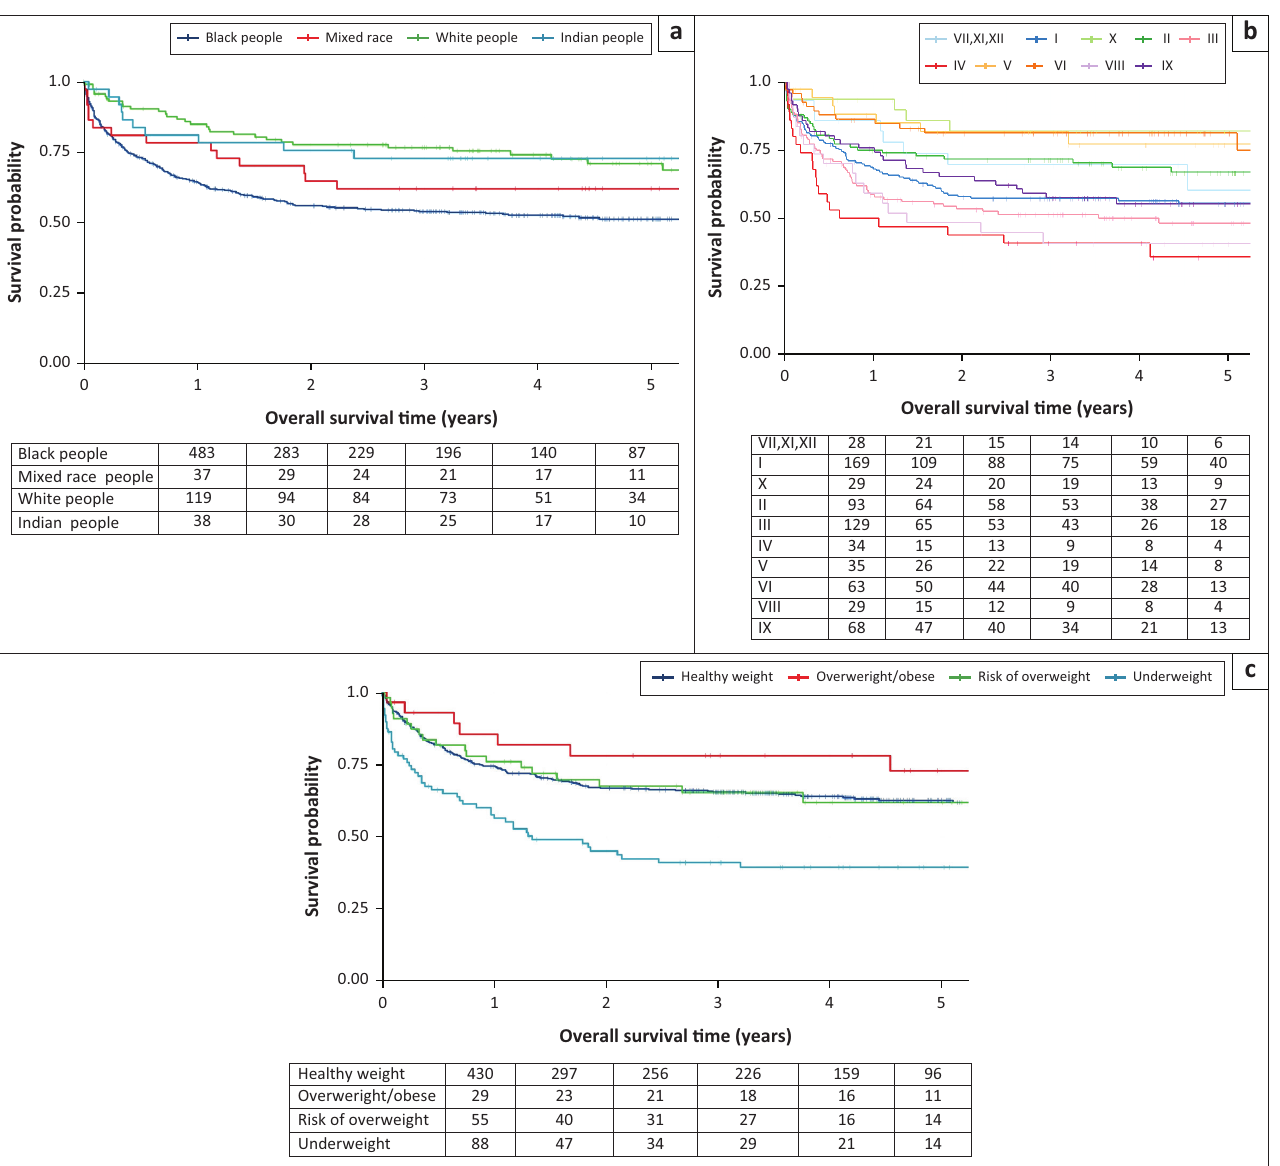
FIGURE 2 : Kaplan-Meier plots showing the effect of (a) ethnicity, (b) International Classification of Childhood Cancers 3rd edition classification and (c) nutritional status, on overall survival in childhood